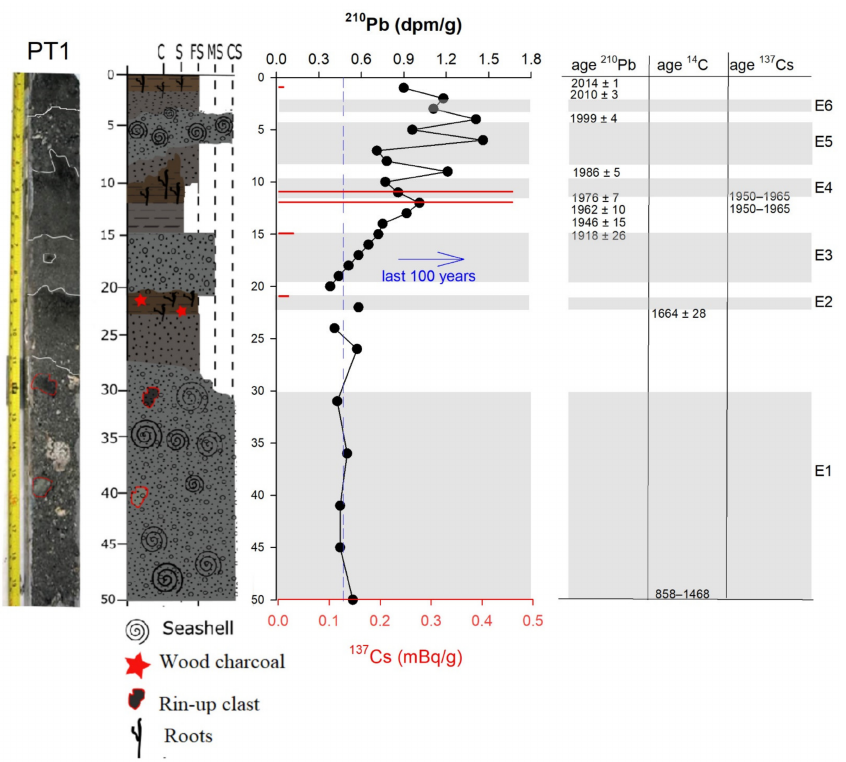
Figure 7. Lithology description, and 210 Pb (black) and 137 Cs (Red) graphic with gray bars indicating the flood and marine events identified, in correspondence with the estimated Cal BC/AD ages from radionuclide activities ( 210 Pb, 137 Cs and 14 C). The calibrated ages were obtained using the calib 8.2 program. For unit 1, an age range was obtained using three reservoir ages according to the values reported for this area (see Table